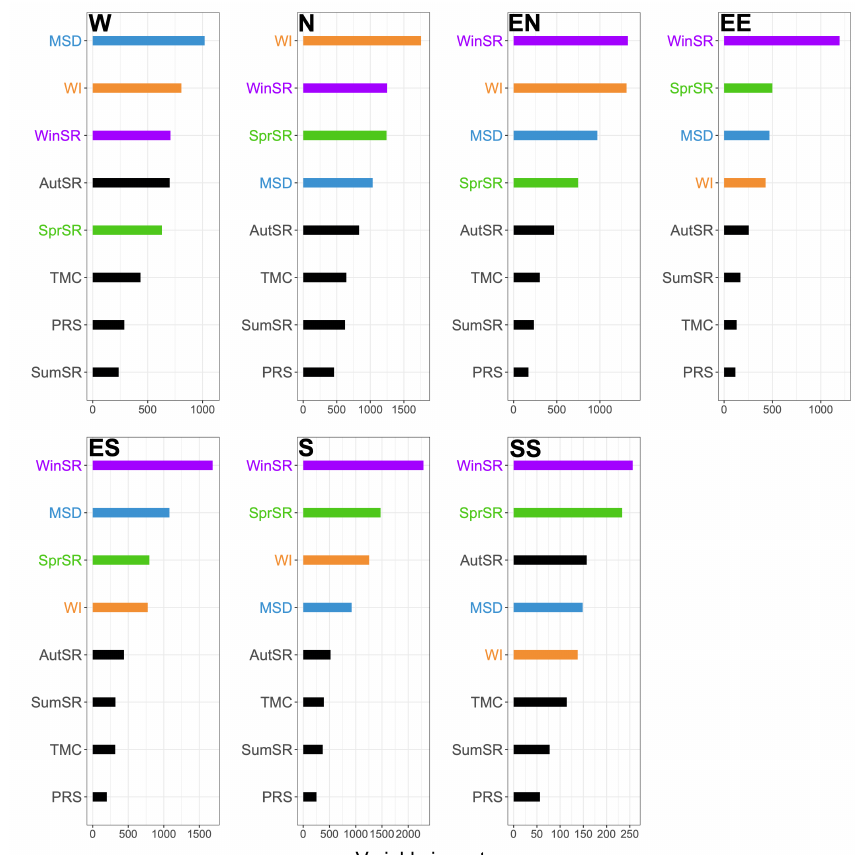
Figure 3. Importance of explanatory climatic variables in each regional group in multivariate random forests (MRF). The importance of each variable was identified based on increased mean square errors in the